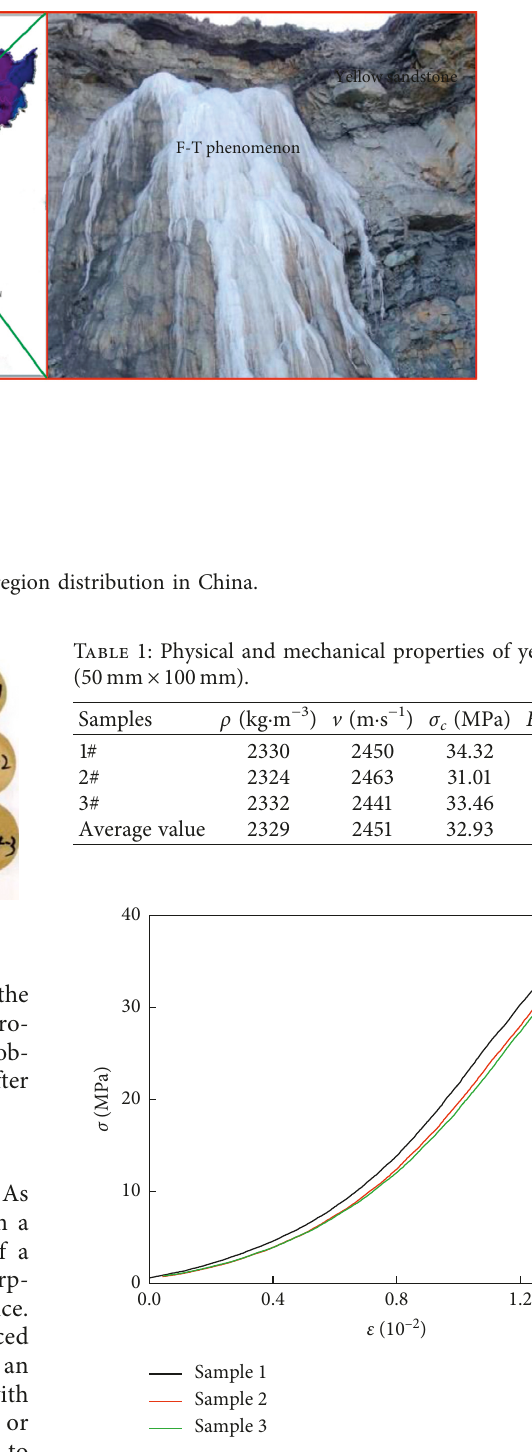
Figure 3: Uniaxial compression stress-strain curve of yellow sandstone.